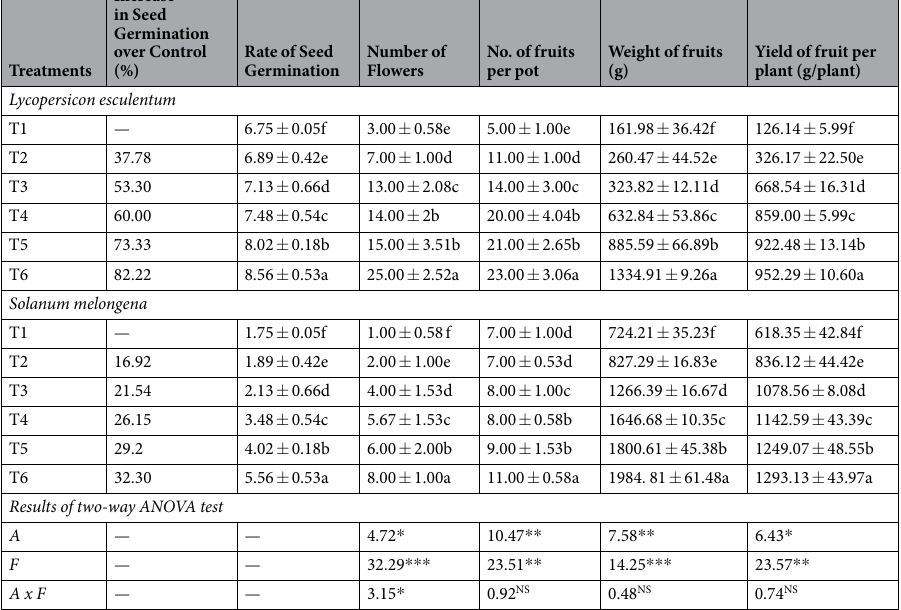
Table 5. Effects of vermicomposted fly ash on the rate of seed germination, number of flowers, fruits per pot, weight of fruits, yield of fruits per plant and percent increase of yield over control in L . esculentum and S . melongena . Values are in Mean ± SD, n = 3 Levels of significance: *** p < 0 . 001 ; ** p < 0 . 01 ; * p < 0 . 05 ; NS = not significant (Two-way ANOVA); ( − ): Two-way ANOVA not applied. Different letters in the same column denote significant differences ( p < 0 . 05 ) in the rate of seed germination, number of flowers, number of fruits per pot, weight of fruits, yield of fruits per plant of L . esculentum and S . melongena , respectively in different treatments (One-way ANOVA; Tukey’s